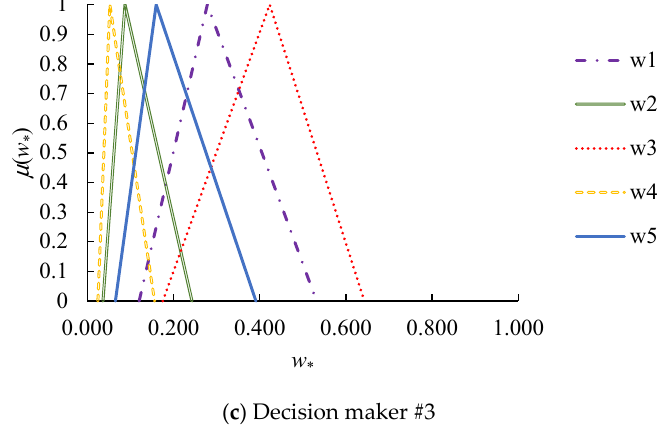
Figure 5. Comparison of the fuzzy priorities of criteria. Subsequently, FWI [38–42] was applied to aggregate the fuzzy priorities derived by Table 1. Fuzzy priorities of criteria derived by all decision makers. The authority levels of the decision makers were subjectively deter- mined by them jointly as 0.5 (father), 0.2 (mother), and 0.3 (daughter), respectively. The aggregation results are shown in Figure 6.